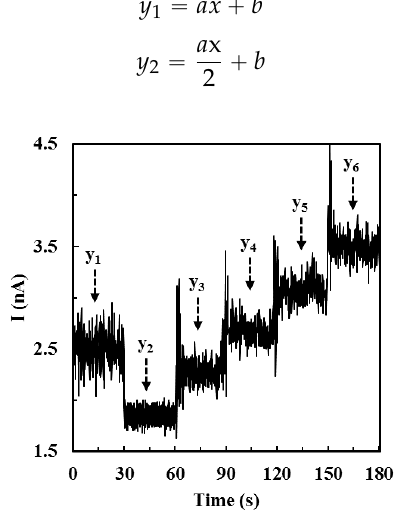
Figure 4. The typical I-t curve when testing ALT biosensors in spiked samples by Method 2 . The measured current signals were represented by y 4 ~ y 6